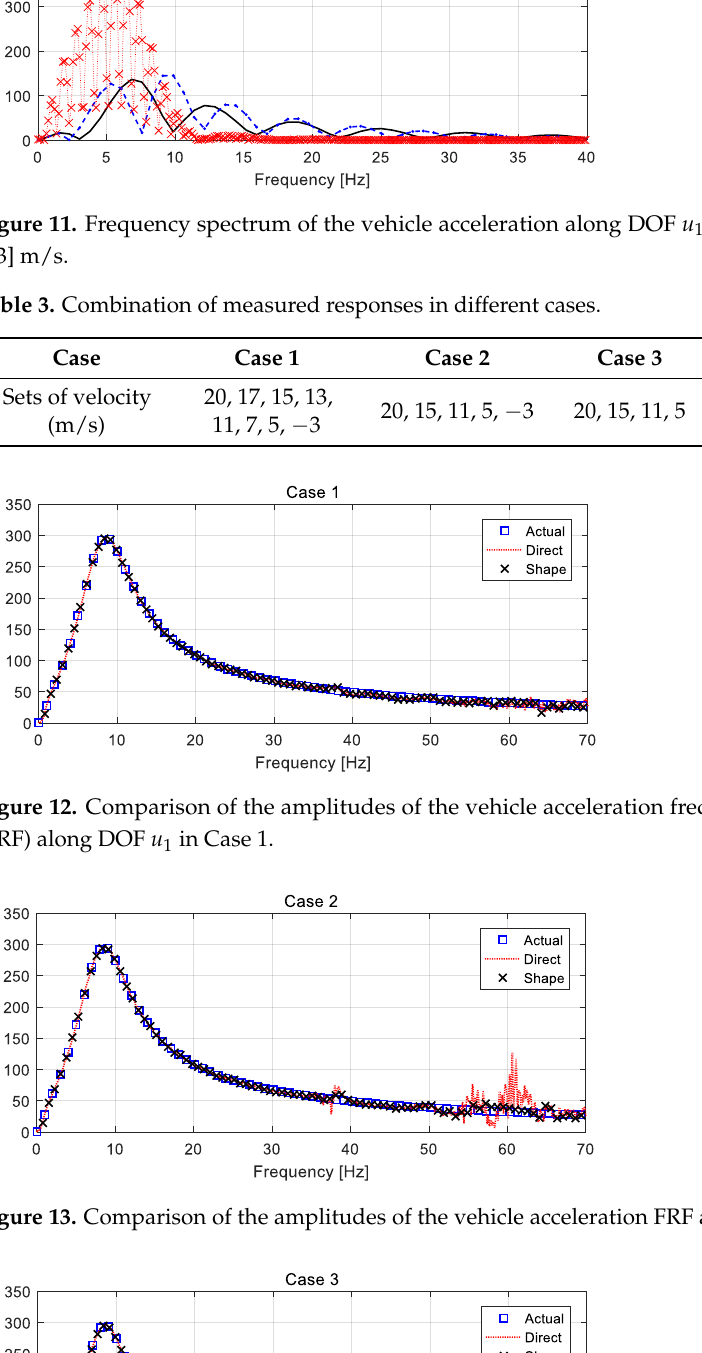
Figure 13. Comparison of the amplitudes of the vehicle acceleration FRF along DOF u 1 in Case 2.